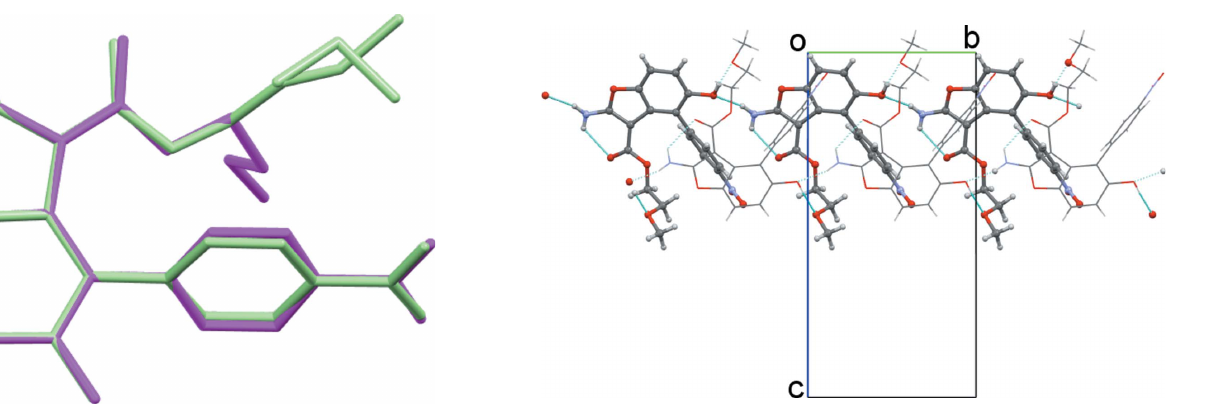
Figure 5 Partial crystal packing of BF1 showing a chain of head-to-tail hydrogen- bonded molecules (intra- and intermolecular hydrogen bonds are indicated by cyan dashed lines). Only the major component of the disordered buthyl group is shown.